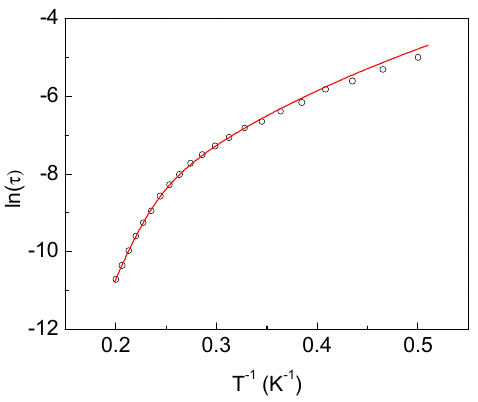
Figure 12. Magnetization relaxation time ln ( τ ) vs. T − 1 plot under the DC field for 2-Dy . The solid is the best fitting plot by Equation (11), C = 4.2 s − 1 , n = 4.8, U eff = 70 K, τ 0 = 2.2 × 10 − 11 s , A = 0, τ QTM − 1 = 0.